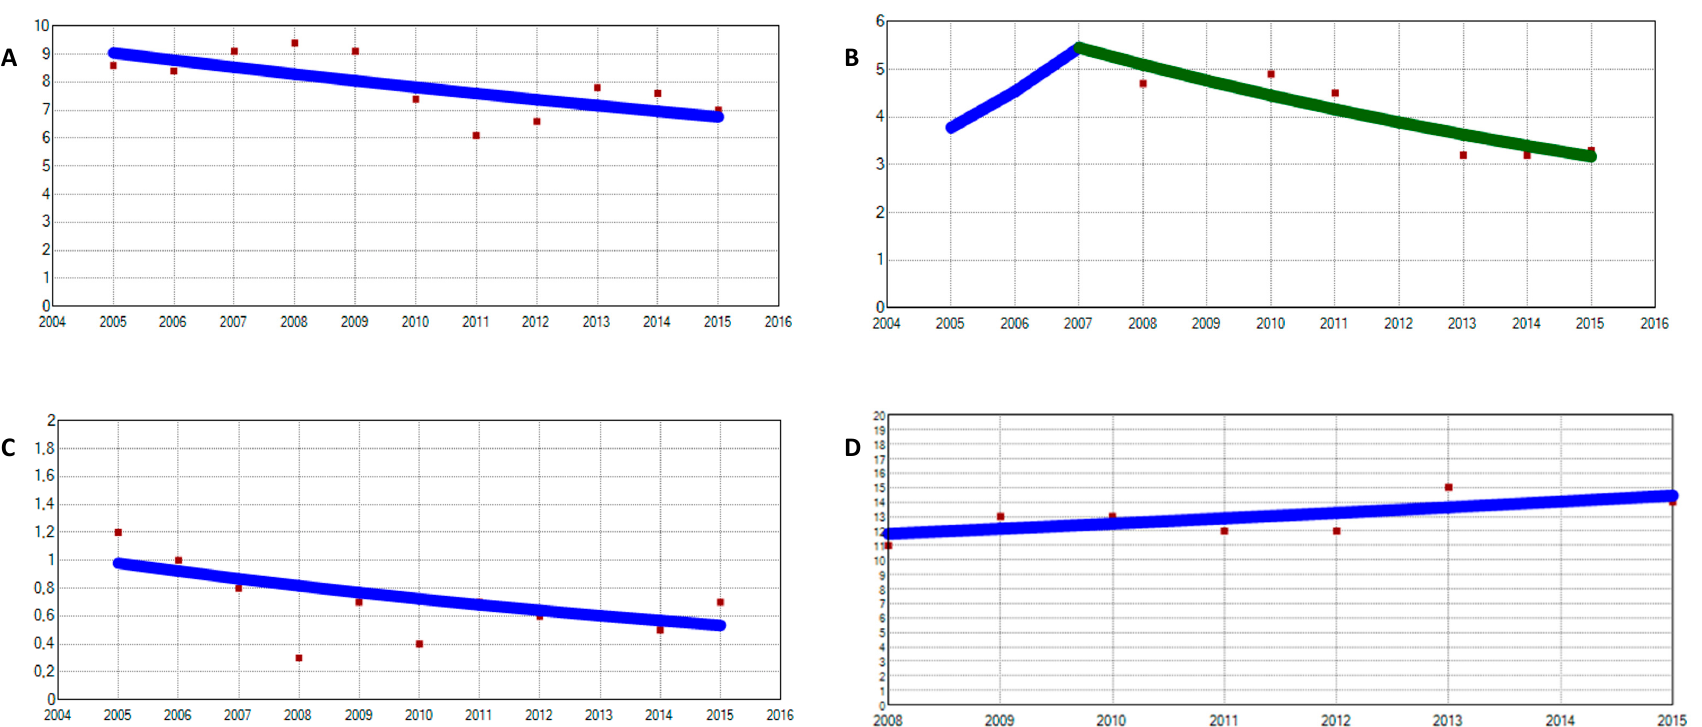
Figure 1. Trends in hospitalization for dementia. Hospitalization rates for dementia per 100,000 inhabitants. Analysis by groups of the dementias studied ( A – D , from top to bottom) with inflection points (joinpoints) and APC. ( A ) Degenerative dementia: 0 joinpoints, APC 2005–2015 − 2.9 (95% CI − 5.5 to − 0.1, p < 0.01 *). ( B ) Vascular dementia, 1 joinpoint (2007) APC 2005–2007 20.1 (95% CI − 11.8 to 63.6, p = 0.2), APC 2007–2015 − 6.5 (95% CI − 9.5 to − 3.5 p = 0.01 *). ( C ) Induced dementia, 0 joinpoints, APC 2005–2015 − 5.9 (95% CI − 10.6 to − 0.9, p < 0.01 *). ( D ) Mild cognitive impairment, 0 joinpoints, APC 2008–2015 2.9 (95% CI − 0.1 to 6, p = 0.01 *). APC: annual percentage change; 95% CI: 95% confidence interval. (*): APC statistically significant. Red dots: exact annual value. Lines represent trends, with line colors changing where joinpoints were identified. A blue line only represents a monotonic trend. X -axis: years (from 2004 to 2016). Y -axis: discharge rate for dementia group or quartile studied; discharge rates for dementia / 1000 hospital discharges. APC: annual percentage of change. 95% CI: 95% confidence interval. Data represent exact annual value. * Statistically significant CAP. Note: some exact annual values (red dots) might be overlapped by the regression line in some graphs (see graph 1B -2005, 2006, and 2007- or graph 1D 2014).